Question: Identify the chart type used in this figure.
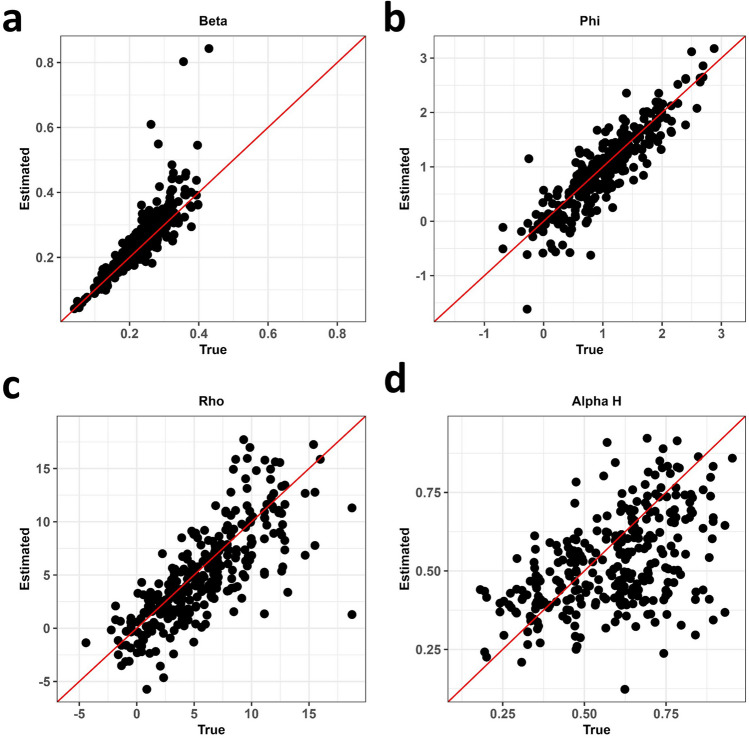
Answer: scatter